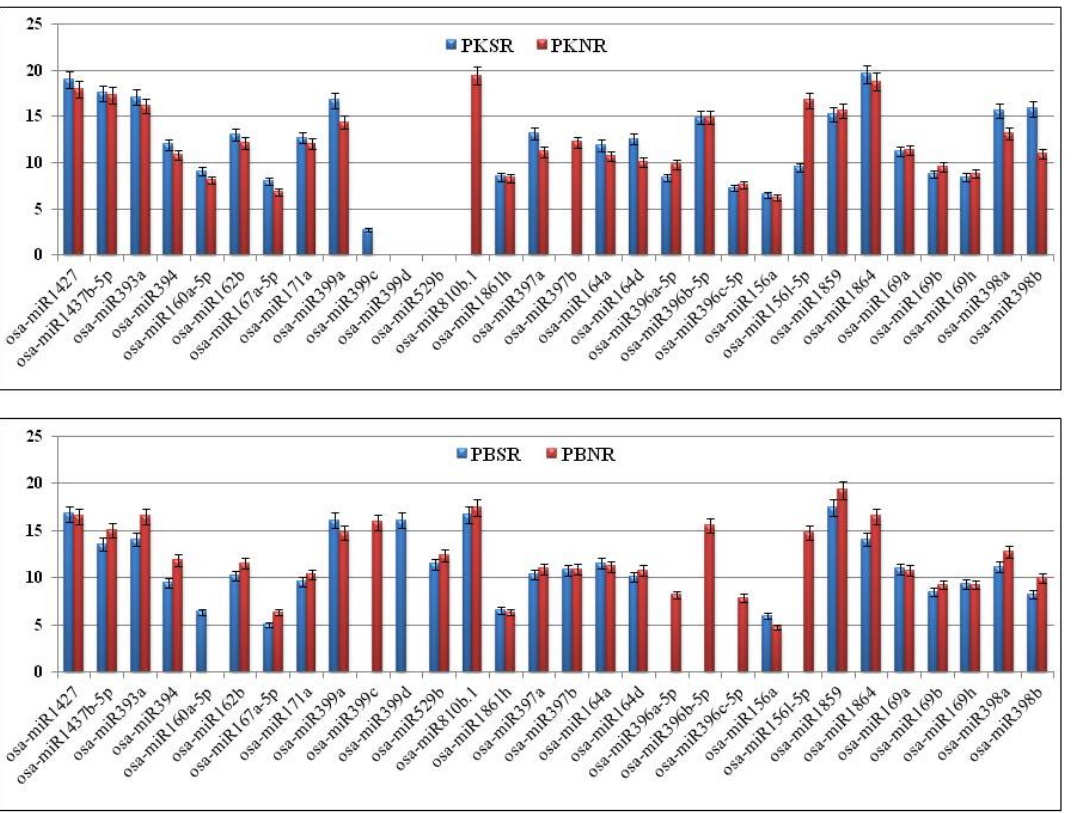
Figure 3. Expression profiles of osa-miRs measured by performing Taqman qRT-PCR in the root tissues of Pokkali (PK) and Pusa Basmati (PB) grown in the presence (SR) and absence (NR) of salt. All experiments were performed in triplicate and the results were normalized using 18S rRNA as the control.